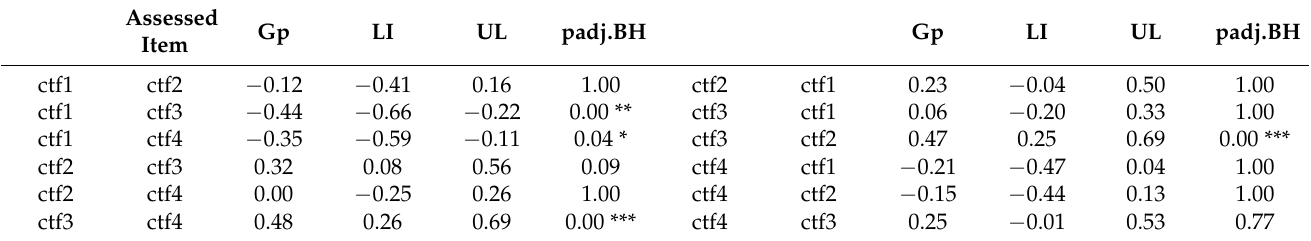
Table 4. Evaluation of local dependence, with partial gamma coefficients.